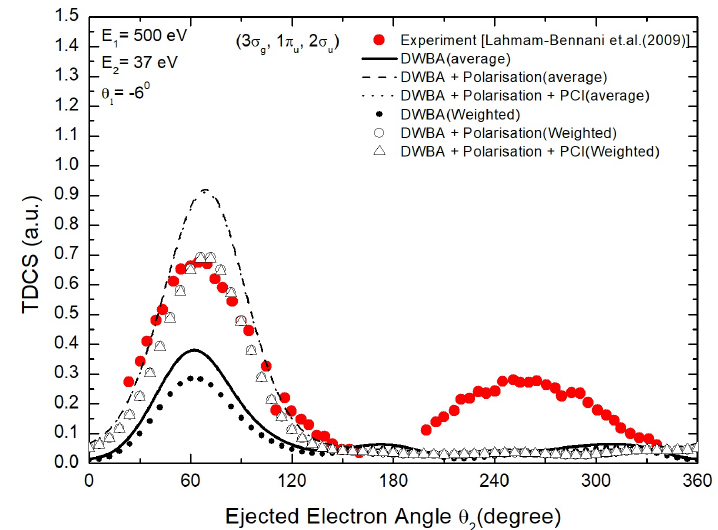
Figure 1. Electron-impact TDCS for N 2 molecule calculated for the weighted and average sum of the outer orbital (3 σ g , 1 π u , 2 σ u ). The ejected electron energy is 37 eV. Kinematics and legends used are displayed in the figure